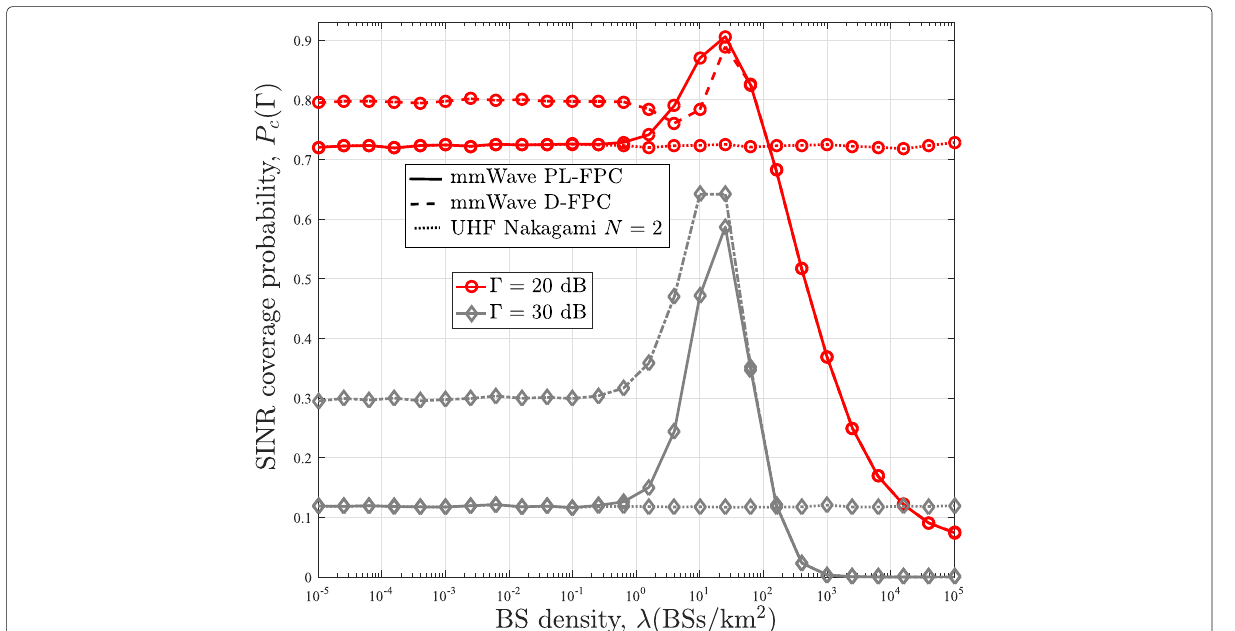
Fig. 9 Comparison of the SINR coverage probability of the mmWave and UHF networks in the uplink channel with the power control factor τ =